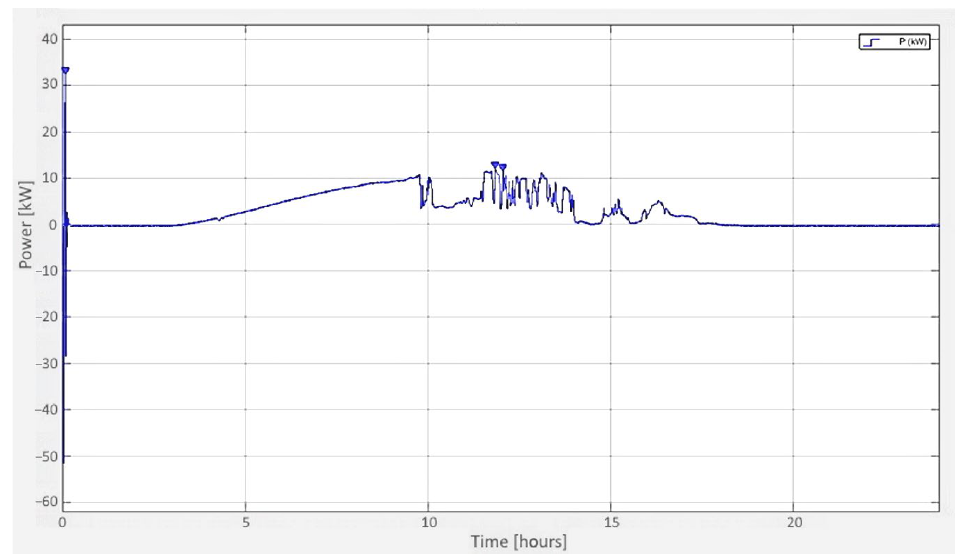
Figure 23. Daily waveform of the power supplied (12.2 kW) to the network on an exemplary day in July.